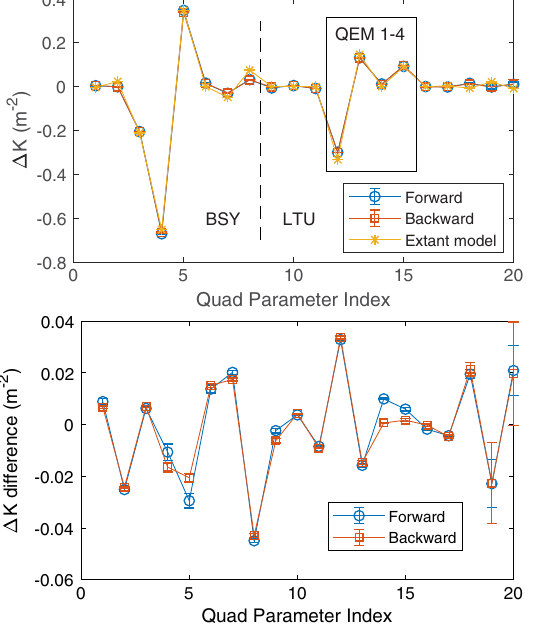
FIG. 13. Top: Gradient changes from the initial model, Δ K , obtained with global fitting for BSY and LTU quadrupole parameters with forward or backward tracking. Also plotted is the actual lattice model in operation when data were taken. Bottom: difference of Δ K between measurements and the Extant model.